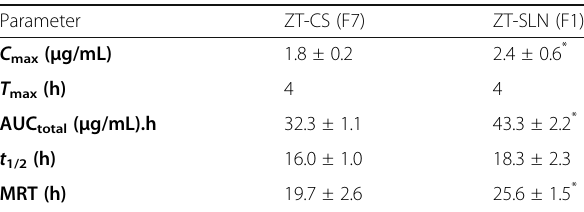
Table 5 Pharmacokinetic parameters of zotepine from zotepine coarse suspension (ZT-CS) and zotepine solid lipid nanoparticle (ZT-SLN) formulations after oral administration in rats (mean ± SD, n = 6) Parameter ZT-CS (F7) ZT-SLN (F1) C max ( μ g/mL) 1.8 ± 0.2 2.4 ± 0.6 * T max (h) 4 4 AUC total ( μ